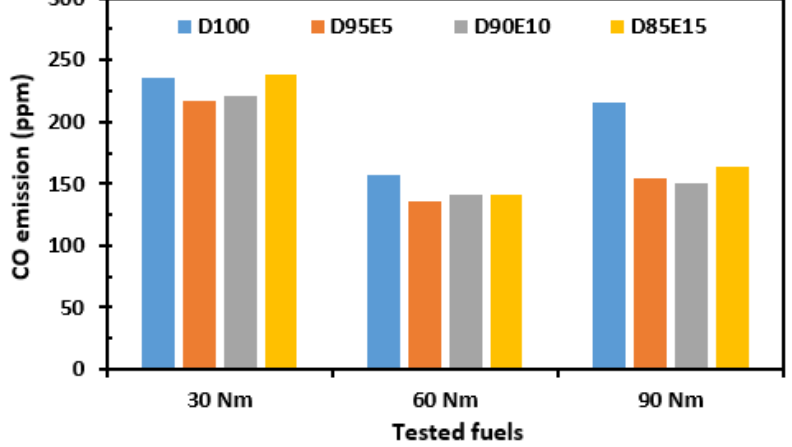
Figure 7. CO emissions for all test fuels according to various engine